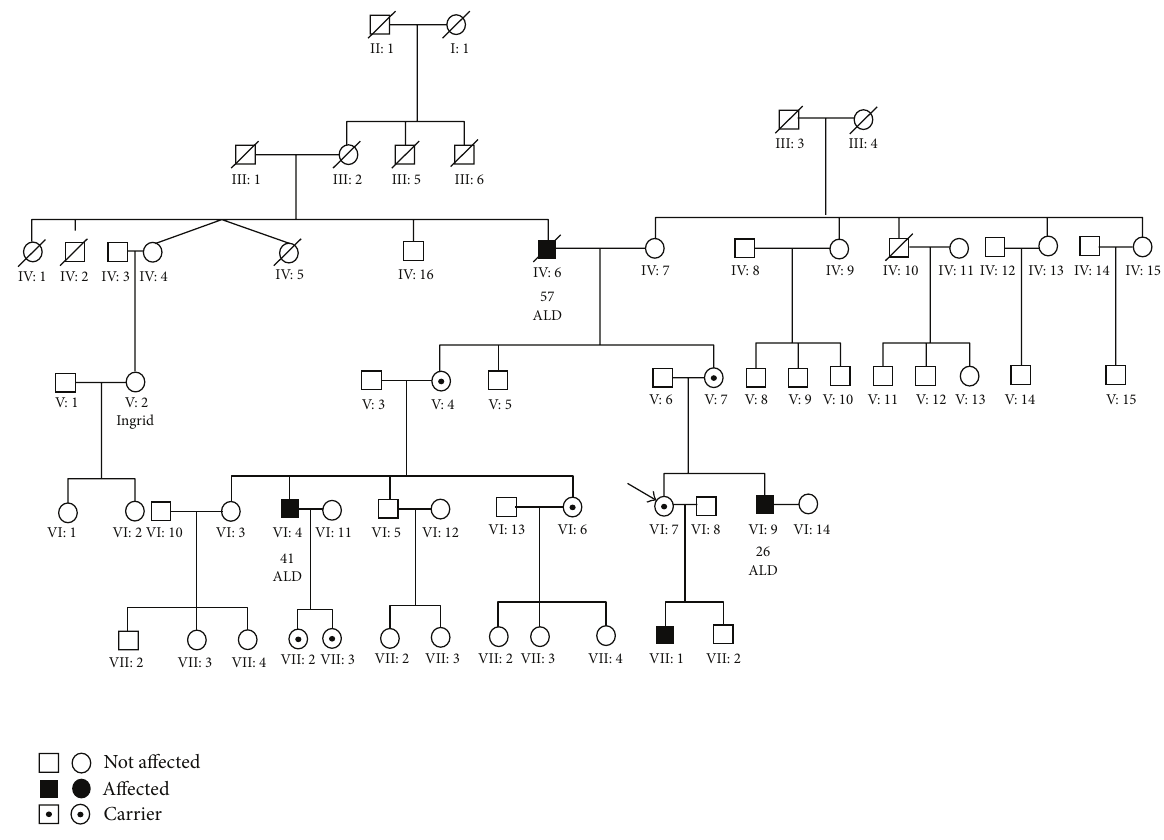
Figure 1: Genetic family diagram. The affected 35-year-old female is